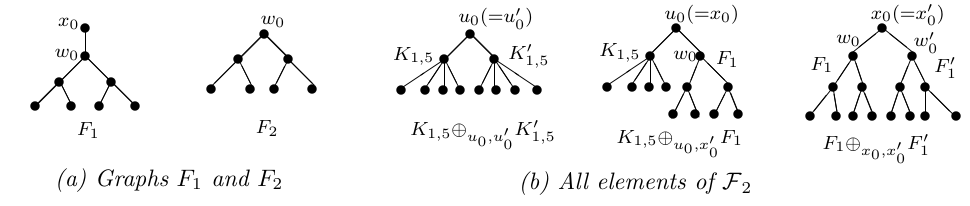
Fig.5. Graphs of